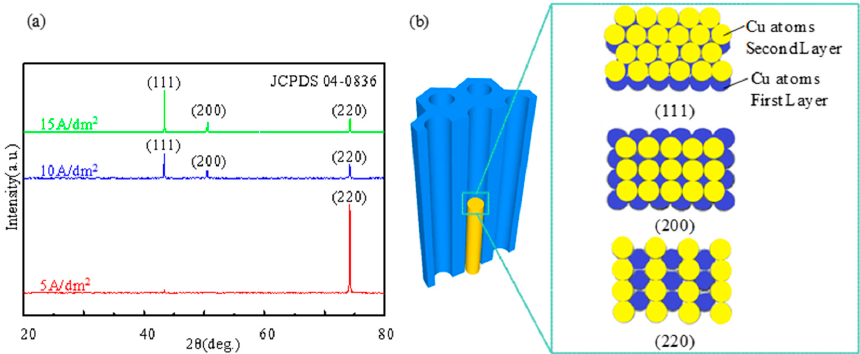
Figure 7. ( a ) X-ray diffraction (XRD) spectrum of CNPs formed with different electric current densities; ( b ) atoms arrangement on different crystal planes.